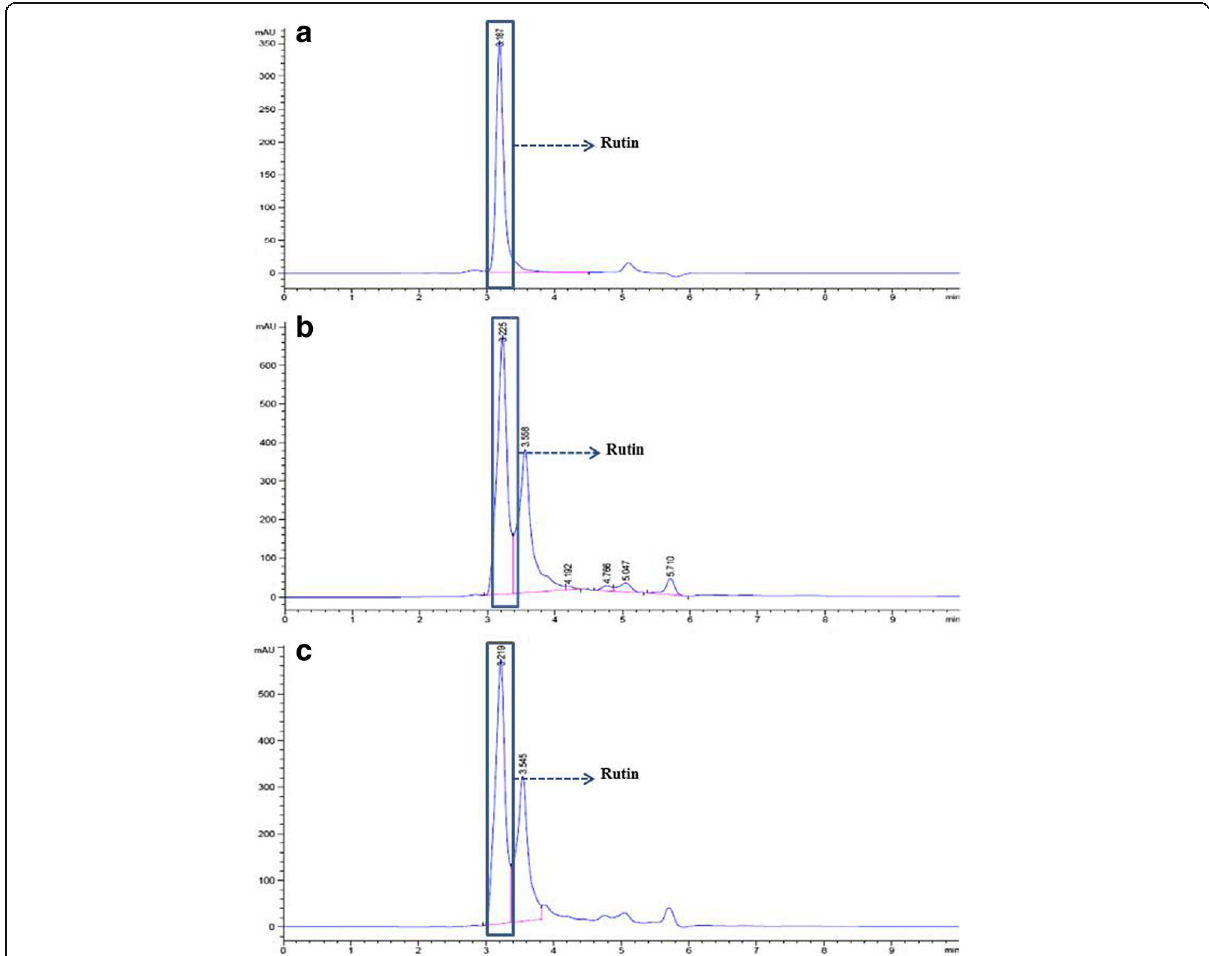
Fig. 3 HPLC chromatogram of rutin a , crude extracts of Uvaria longipes b and Dasymaschalon sp. ( c ). Arrows show the peaks corresponding to the standard